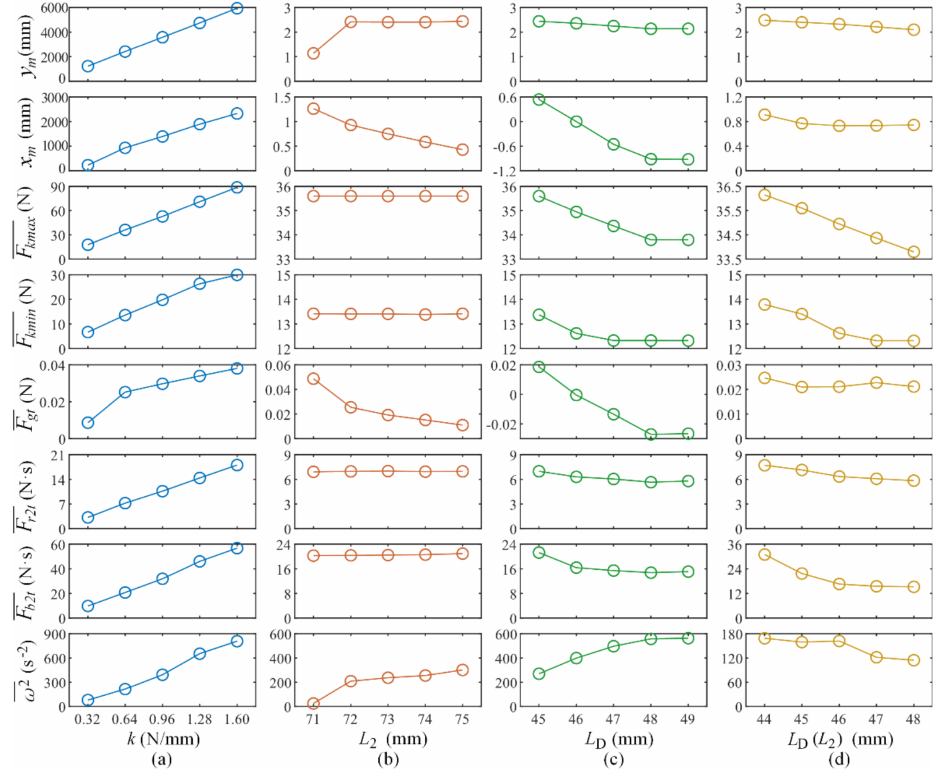
Figure 9. Jumping performance influenced by changing the design parameters (abscissa: altered parameter; ordinate: influence indicator): ( a ) the indicators of ejection performance influenced by the change of the parameter k ; ( b ) the indicators of ejection performance influenced by the change of the parameter L 2 ; ( c ) the indicators of ejection performance influenced by the change of the parameter L D ; ( d ) the indicators of ejection performance influenced by the change of the parameters L D and L 1